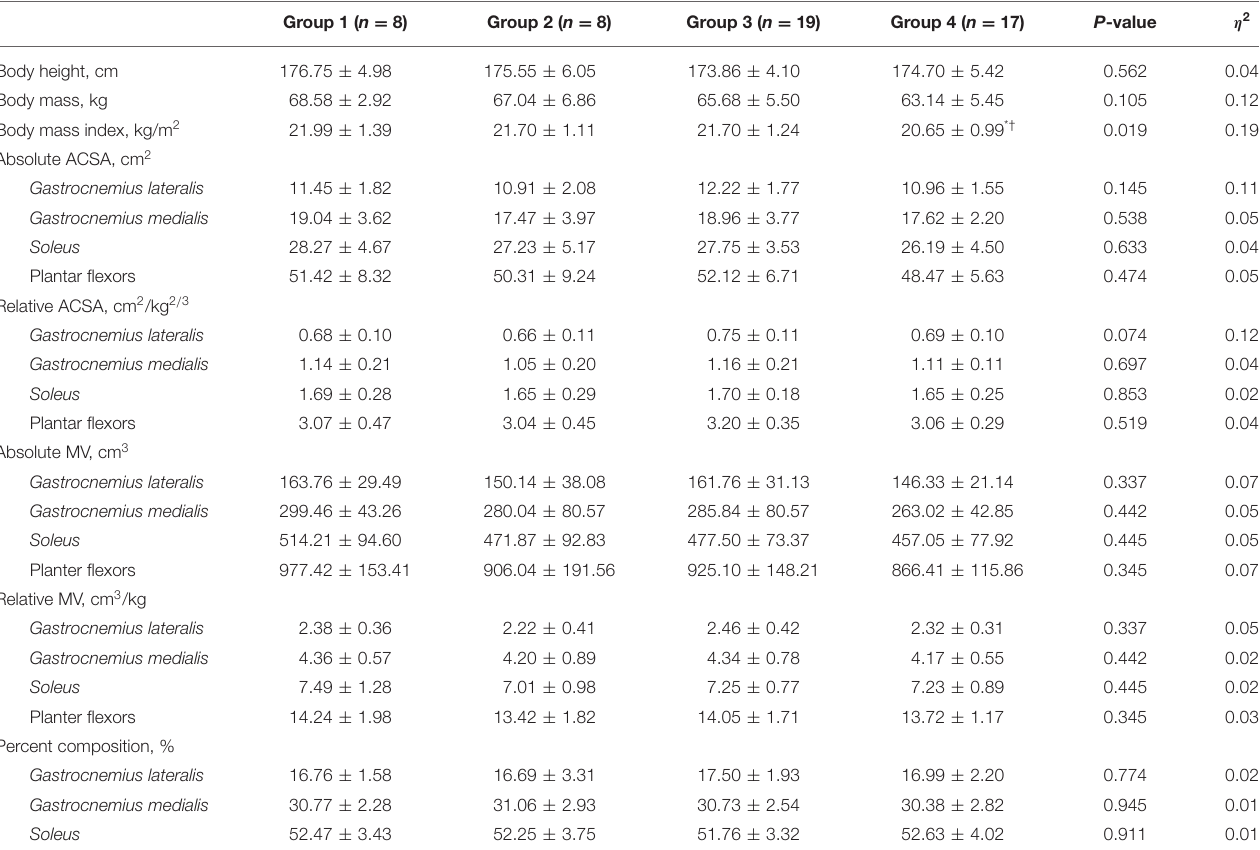
TABLE 2 | Physical characteristics and plantar flexor muscle size variables in four sprint performance level groups of sprinters based on their personal best 100-m sprint